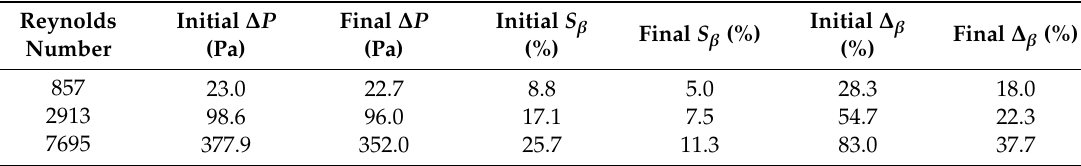
Figure 12. Comparison of flow uniformity metrics in the initial and modified collector geometries. Table 5. Initial and final values of pressure drop, S β and ∆ β in riser tubes before and after modification of riser diameters for flow uniformity